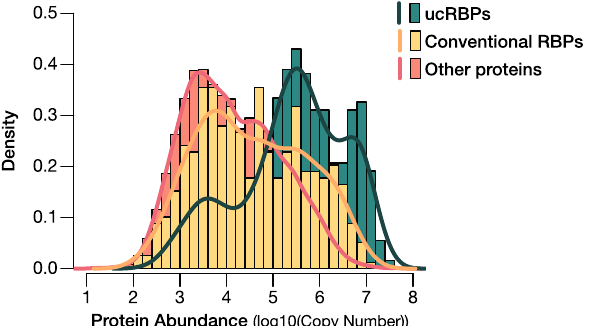
Figure 6. Protein abundance profiles of RBPs. Protein copy number estimates 52 were cross-referenced with the ucRBPs analyzed in this study and conventional RBPs previously identified. Histograms show the distribution of protein abundance (log10 values of protein copy number) for ucRBPs analyzed in this study (green), conventional RBPs (yellow), and all other proteins